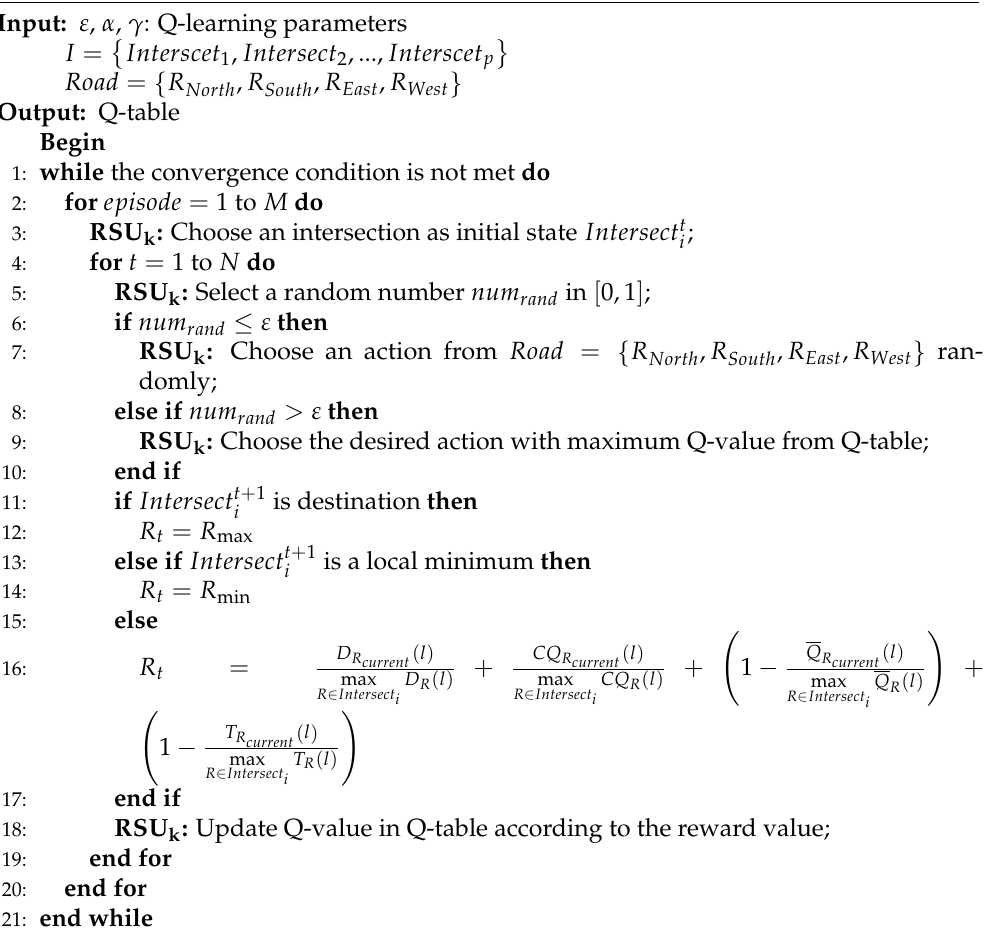
Algorithm 2 Q-learning-based routing algorithm (I2I